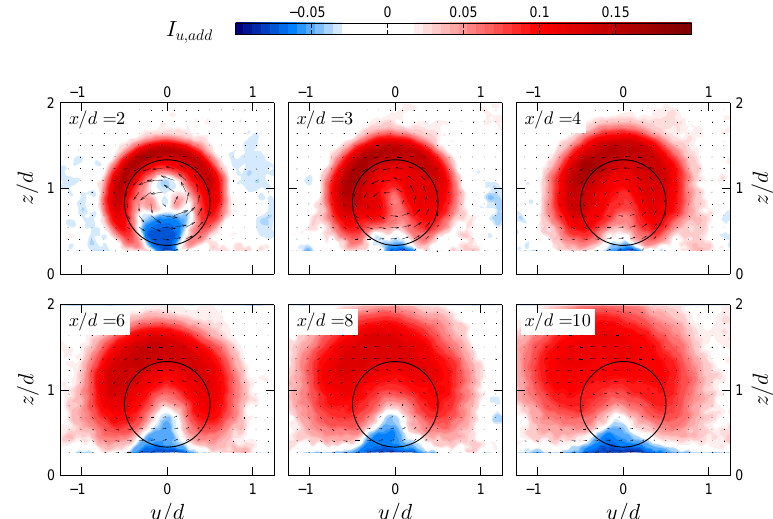
Figure 10. Contours of the added streamwise turbulence intensity I u , add in yz planes at different downstream locations for the miniature turbine operating at λ = λ o . The vector field represents the in-plane velocity components. The black circles show the frontal area of the wind